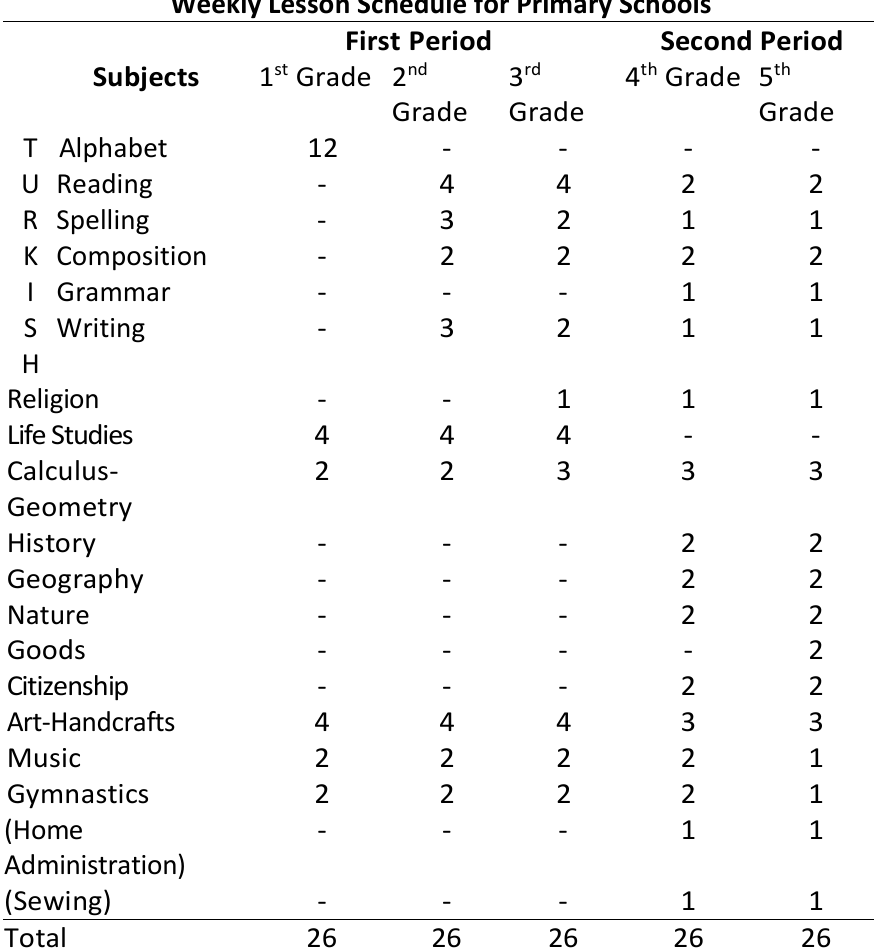
Table 1. The 1926 curriculum and weekly course schedule of the Life Studies course Weekly Lesson Schedule for Primary